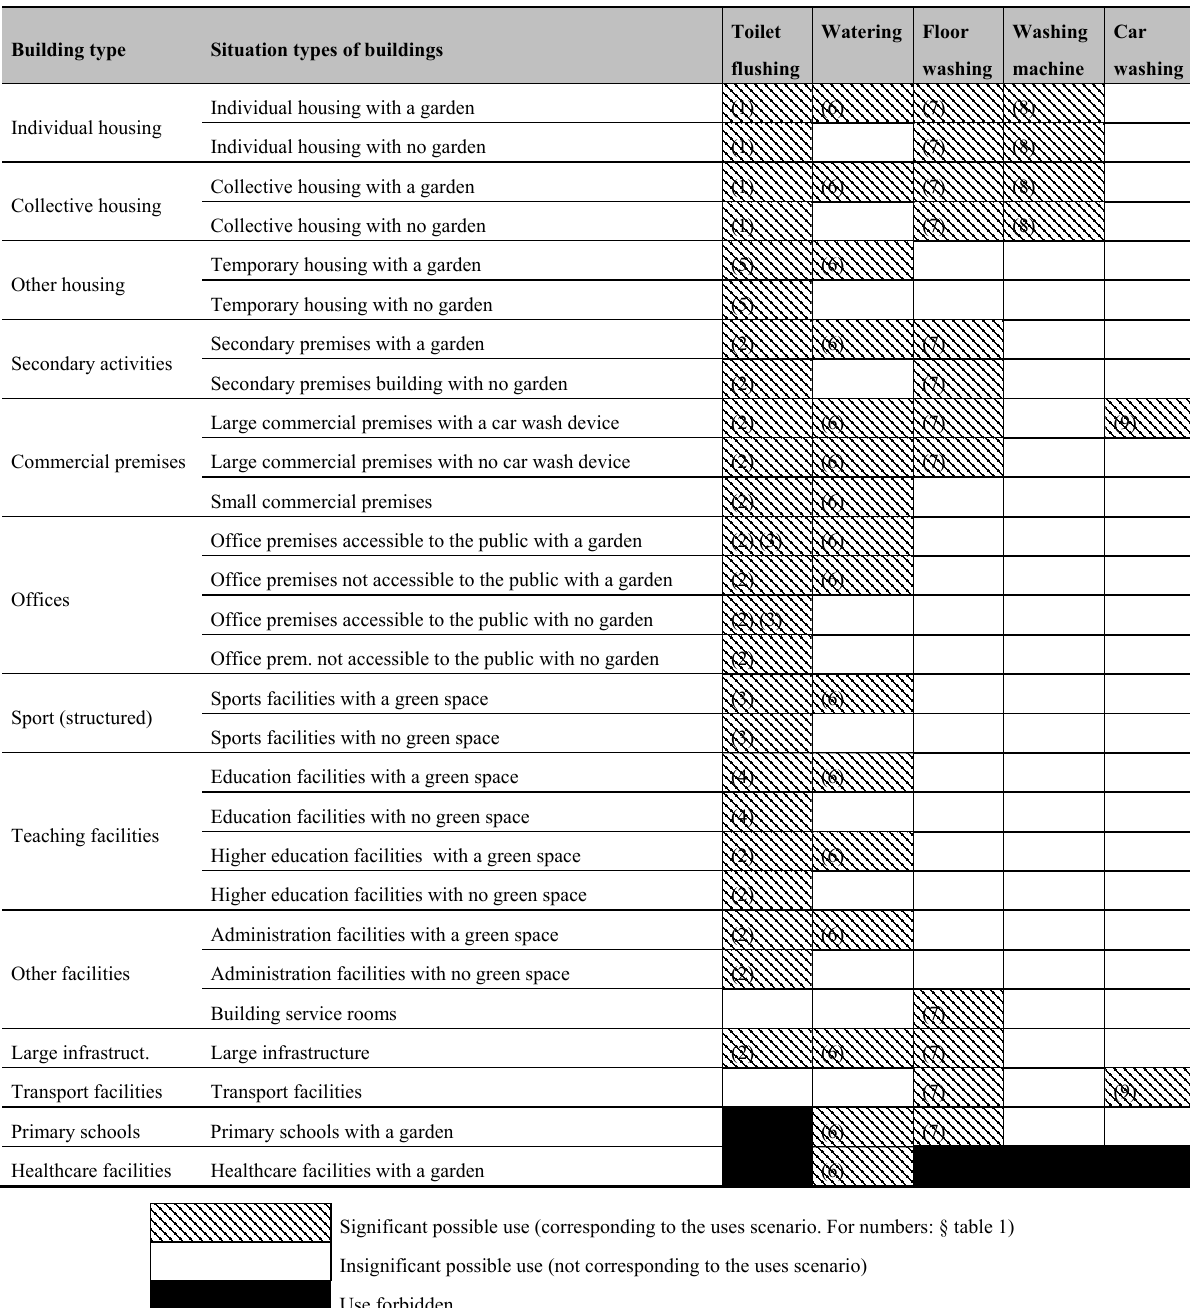
Table 2. Uses scenarios per